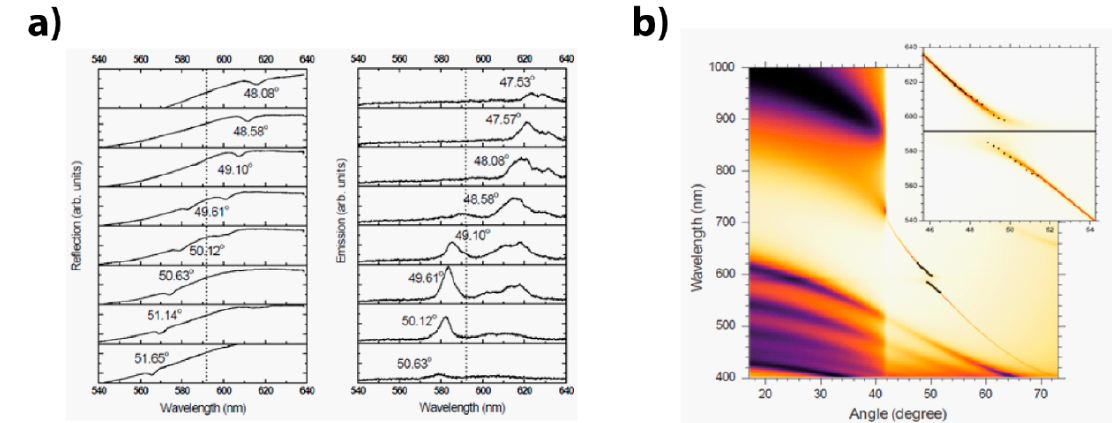
Figure 3. ( a ) Reflectivity ( left ) and photoluminescence ( right ) spectra taken at different angles of incidence with respect to the normal to the sample inside prism. The dashed line is the molecule absorption peak position [38]. ( b ) Experimental data (dots) superimposed to the theoretical calculation of the reflectivity as a function of wavelength and angle of incidence. The anticrossing behavior (distinctive of strong coupled systems) is evidenced in the inset (the horizontal black line is the exciton transition). Reproduced with permission from G. Lerario et al., Optics Letters 39 (7), 2068, © [Optical Society of America], 2014 [38].